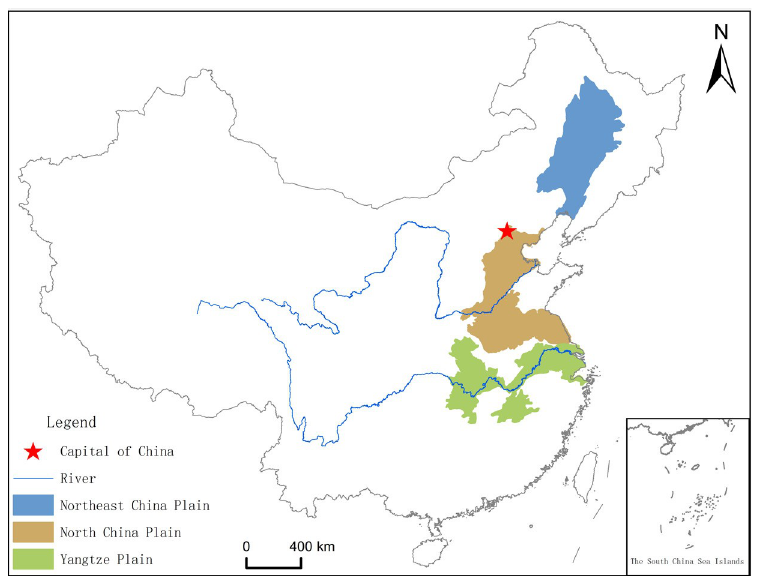
Fig 2. Map of the case study